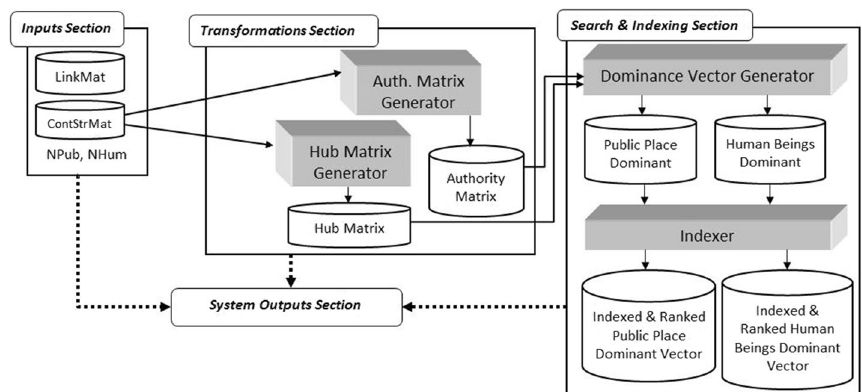
Fig. 3 The search engine workflow (Source: Eze